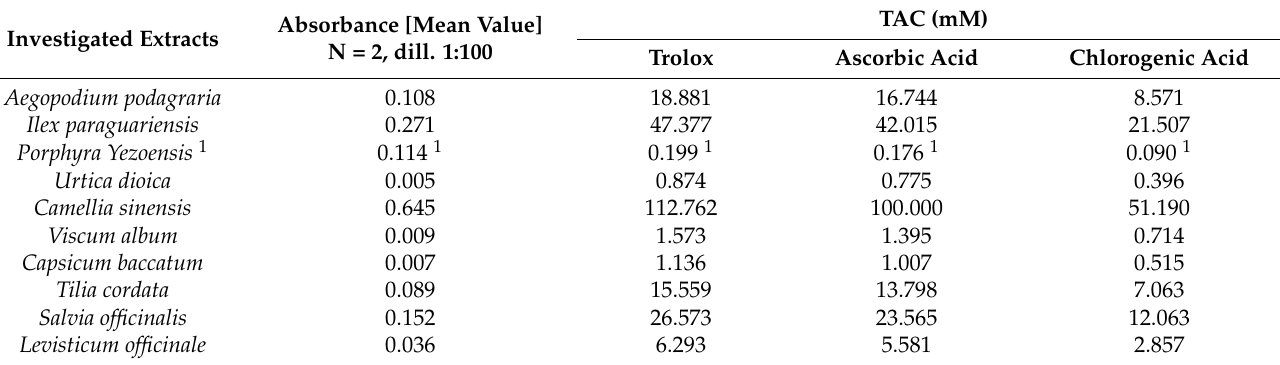
Table 2. The values of the equivalents of the reference substances, i.e., Trolox, ascorbic acid, and chlorogenic acid for the tested extracts, calculated on the basis of calibration graphs made by the CUPRAC method with the Antioxidant Assay